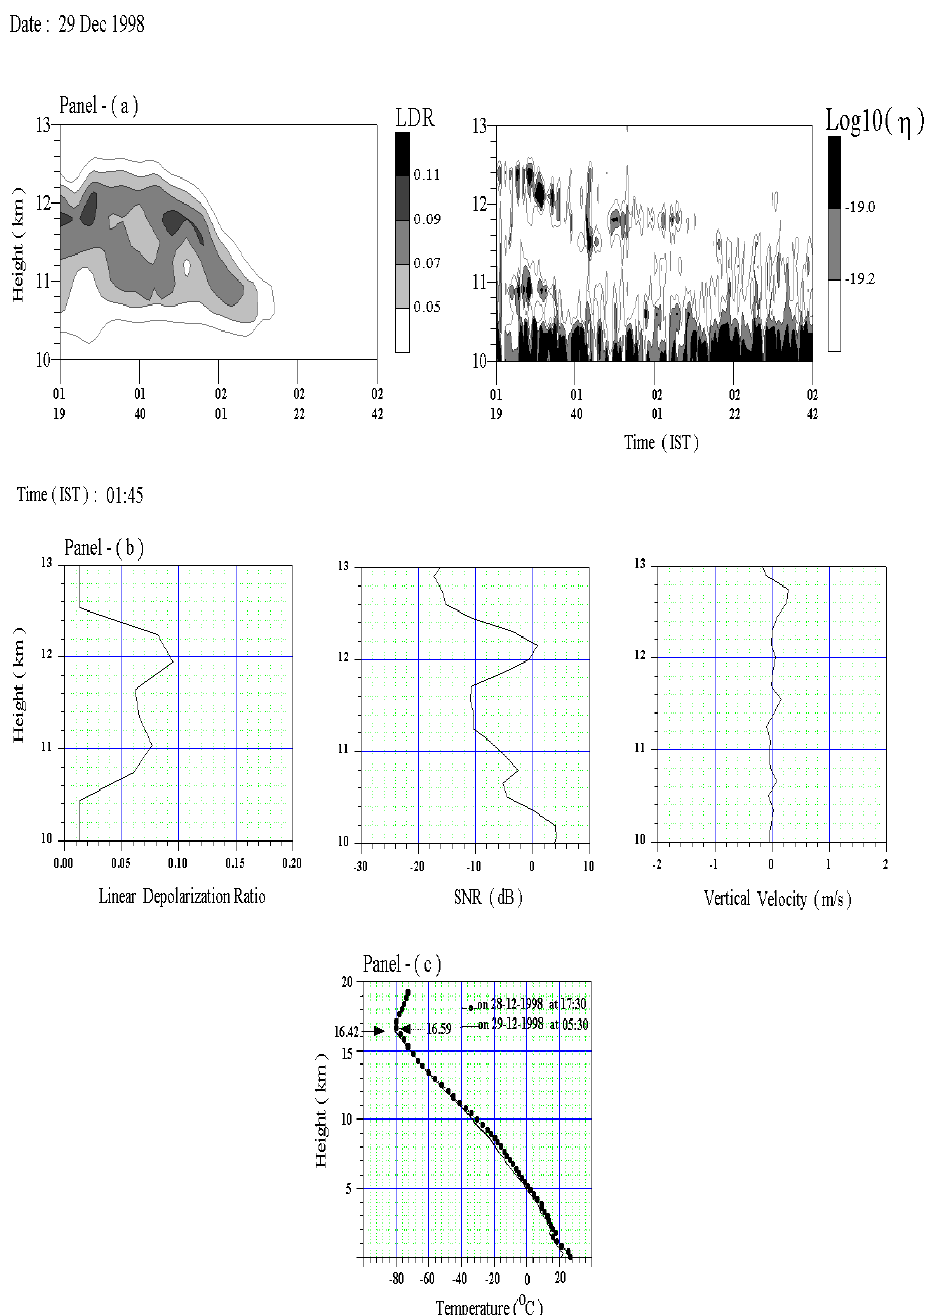
Fig. 4. Panel (a) Range-Time plot of radar reflectivity and lidar LDR during the passage of cirrus on 29 December 1998 (Case 2). The X-axis represents the time scale in hrs, min. Panel (b) Height profiles of lidar LDR, radar SNR vertical beam and vertical velocity at 01:45 h (IST) on 29 December 1998 (Case 2) during the passage of cirrus over the site. Panel (c) Radiosonde temperature profiles obtained at 17:30 h (IST) on 28 December and 05:30 h (IST) on 29 December 1998. Arrows show that cold point tropopause is detected using these temperature